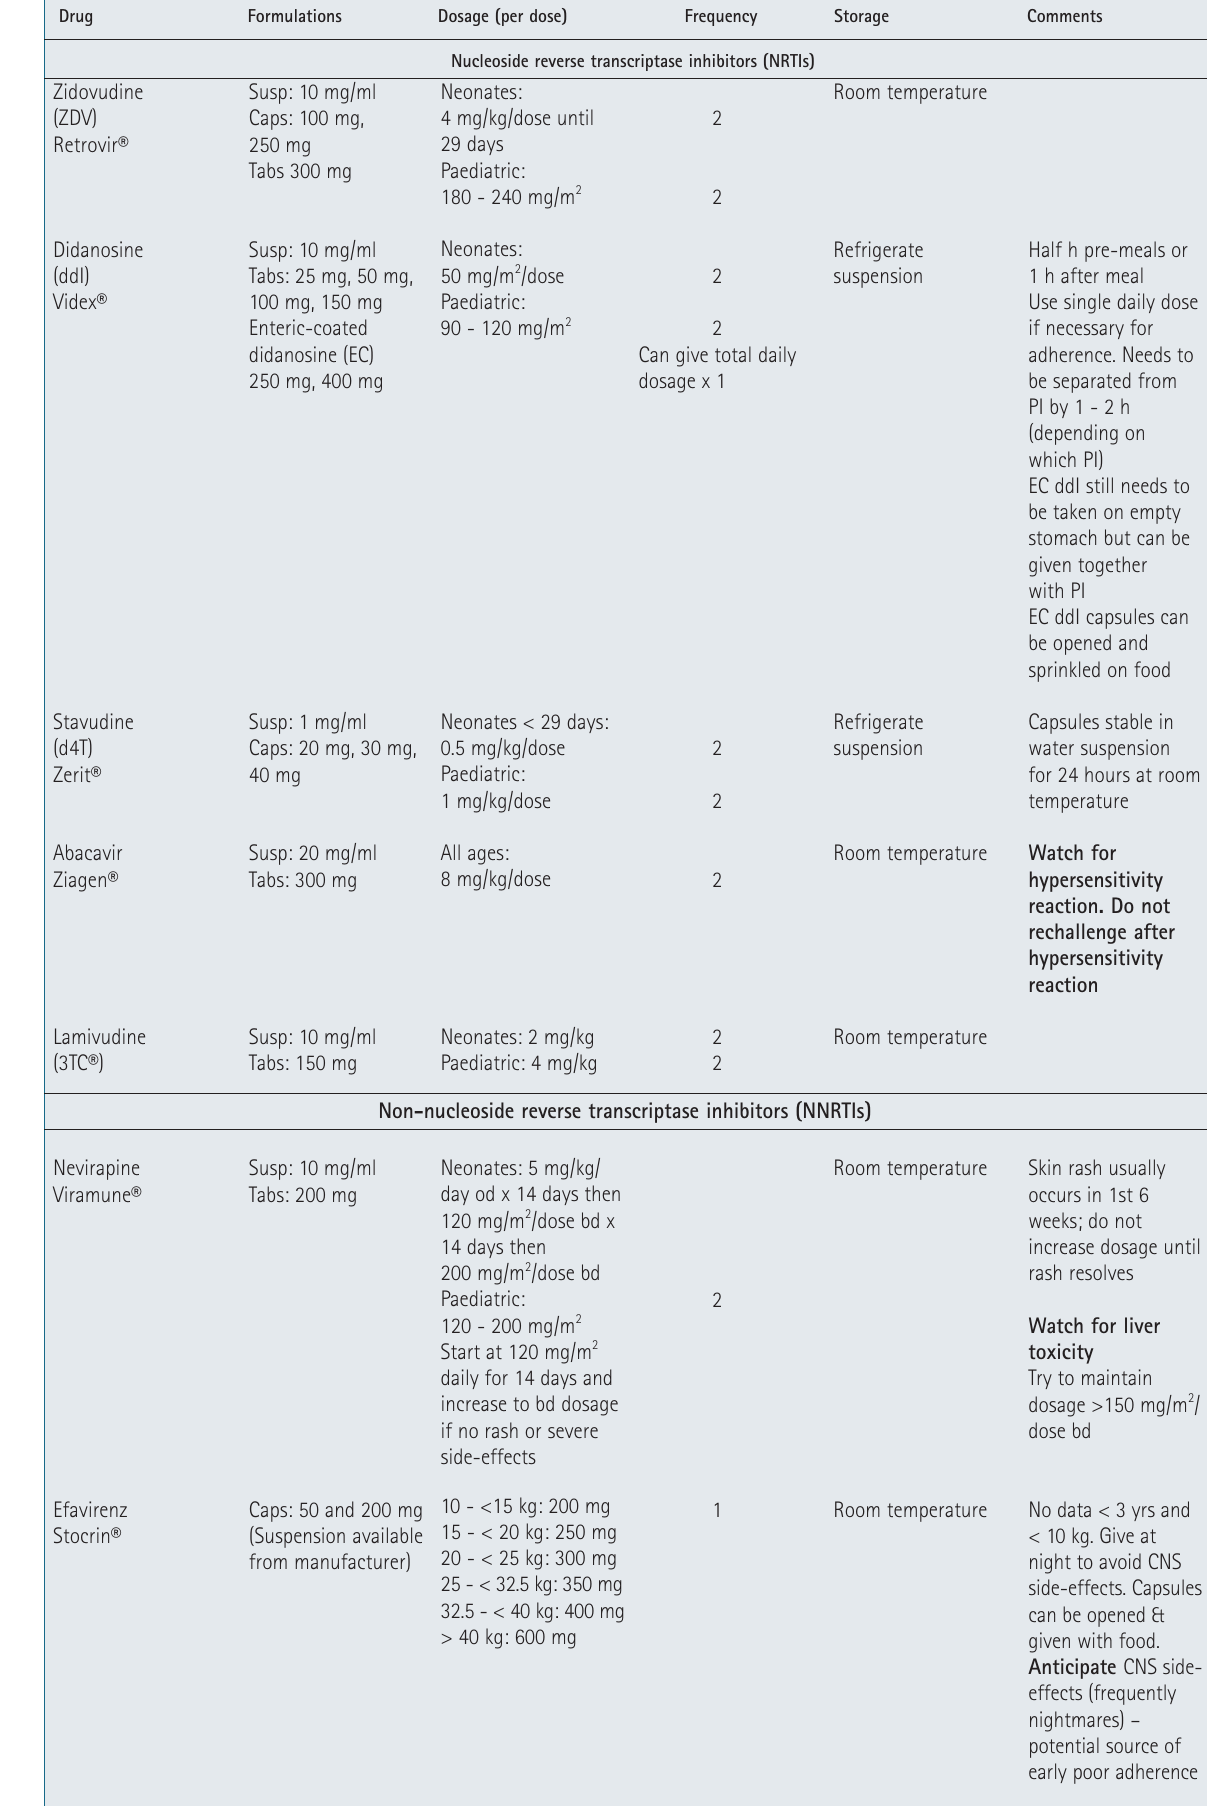
TABLE VIII. DOSAGE AND FREQUENCY OF ARVs IN